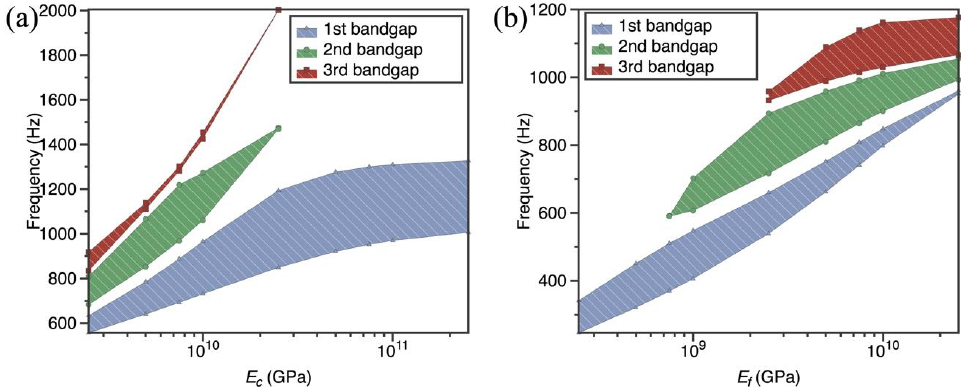
Figure 9. Effect of material parameters of lattice core and face-sheets on bandgaps of the SPLCRR. ( a ) elastic modulus of lattice rod E c ( b ) elastic modulus of face-sheets E f